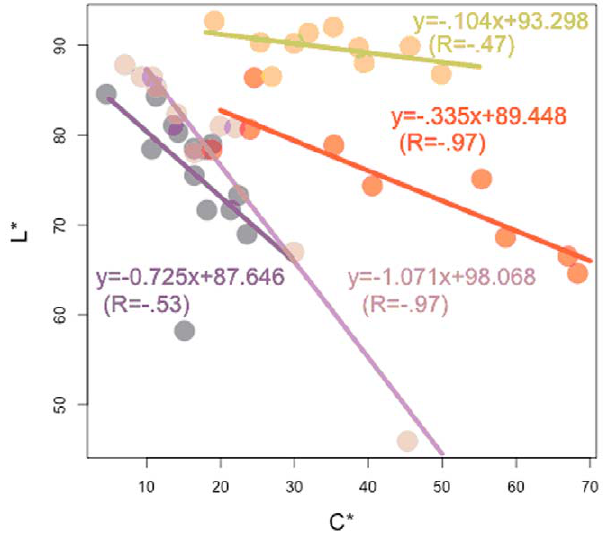
Figure 5. The multivariate relationships between C * and L * values, showing different patterns depending on petal colors, purple, red, orange, and yellow (see Fig. 1), in Lycorislongituba